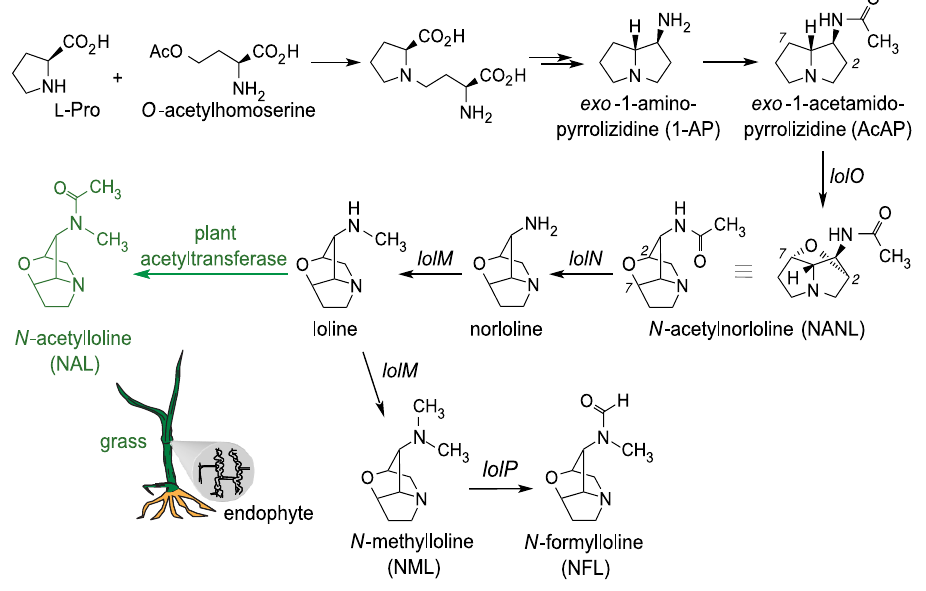
Fig. 8. Summarized loline-alkaloid biosynthetic pathway. Labeled arrows are for steps that contribute to diversity of the lolines. Presence or absence of functional copies of lolO, lolN, lolM , or lolP , or a plant acetyltransferase activity, determine which alkaloids accumulate in the symbiotic plant as the pathway end- products.